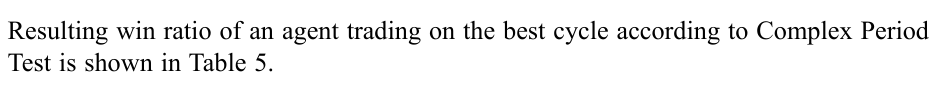
Table 5. Resulting win ratio of an agent trading on the best cycle according